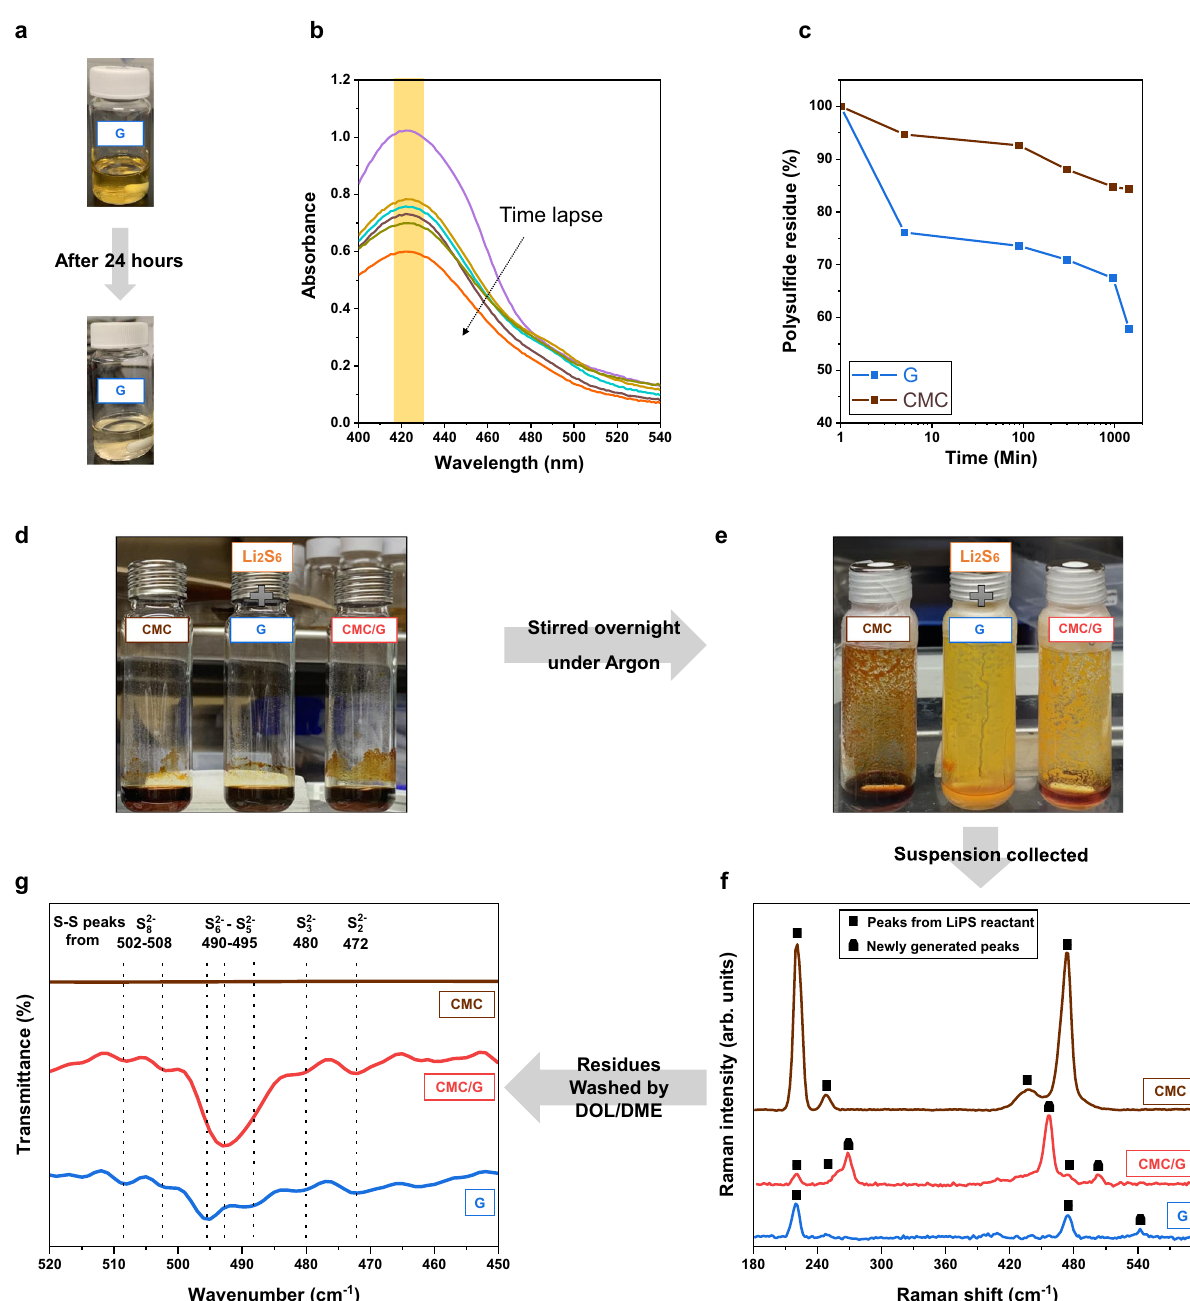
Fig. 2 Polysul fi de adsorption study. Adsorption tests via UV – Vis. a Evolution of polysul fi de with glucose in DOL/DME electrolyte solution; b UV – Vis spectrum of Li 2 S 6 with glucose in DOL/DME electrolyte solution after a speci fi c time; c comparison of LiPS adsorption between CMC and glucose. d , e Illustrating the evolution of polysul fi de in the presence of high concentrate lithium polysul fi de; f Raman spectra of suspensions and g FTIR spectra of washed solid